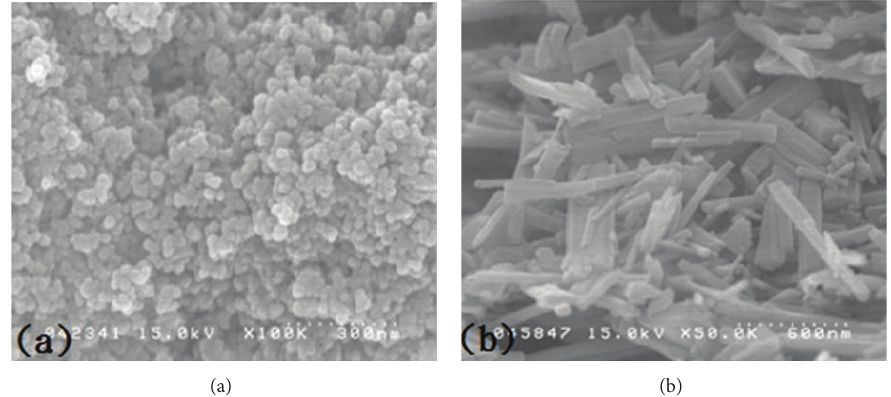
Figure 2: Surface morphology of TiO 2 thin films prepared by (a) commercial particles and (b) hydrothermal method.